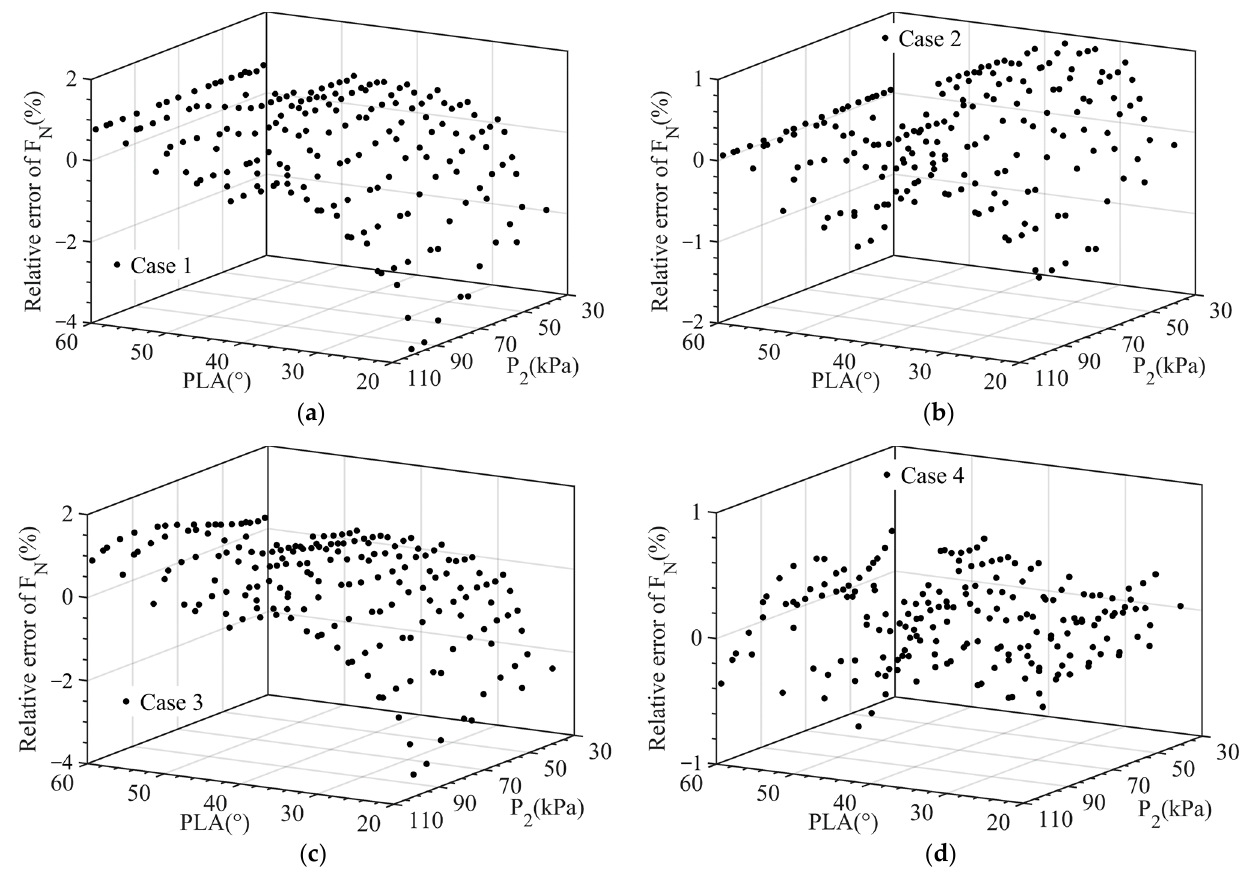
Figure 11. Relative errors of the parameter F N